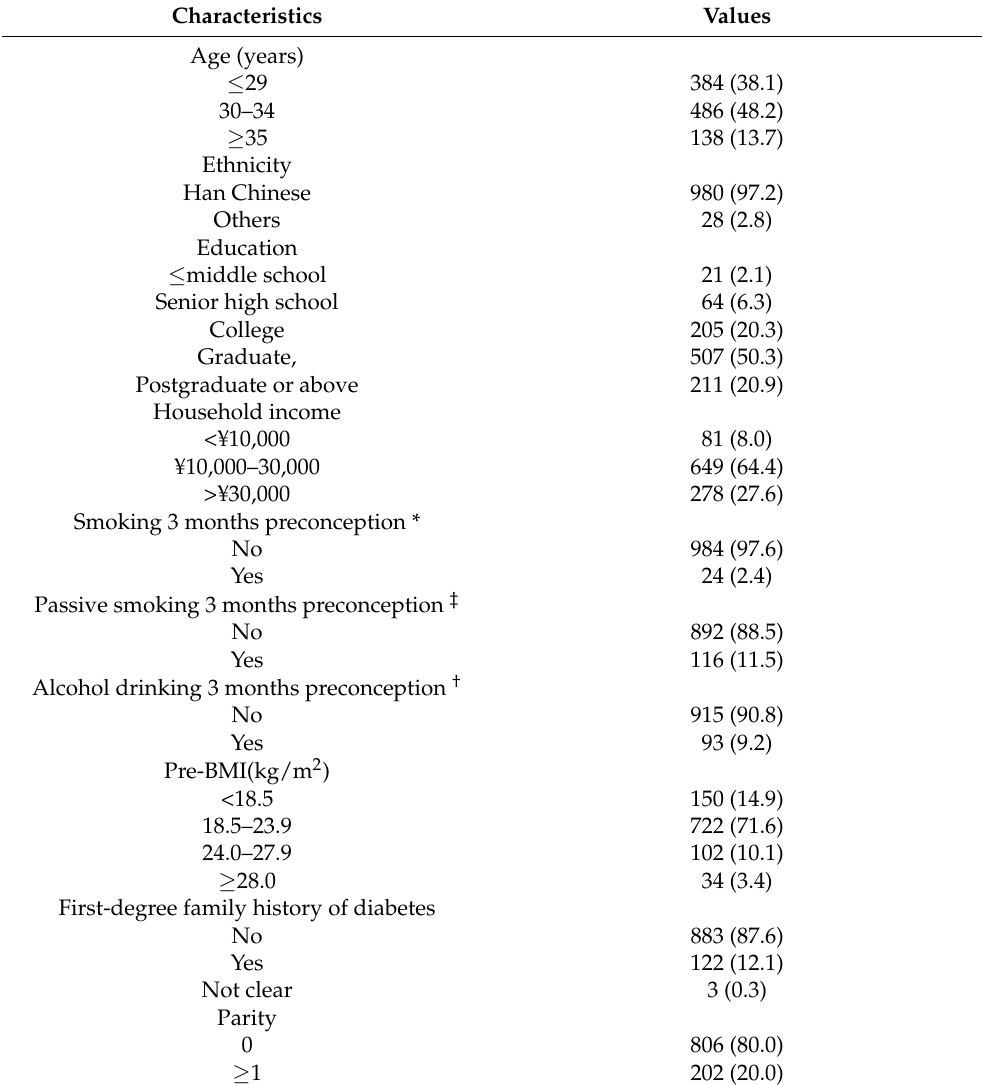
Table 1. Characteristics of 1008 study participants in the cohort, Shanghai,